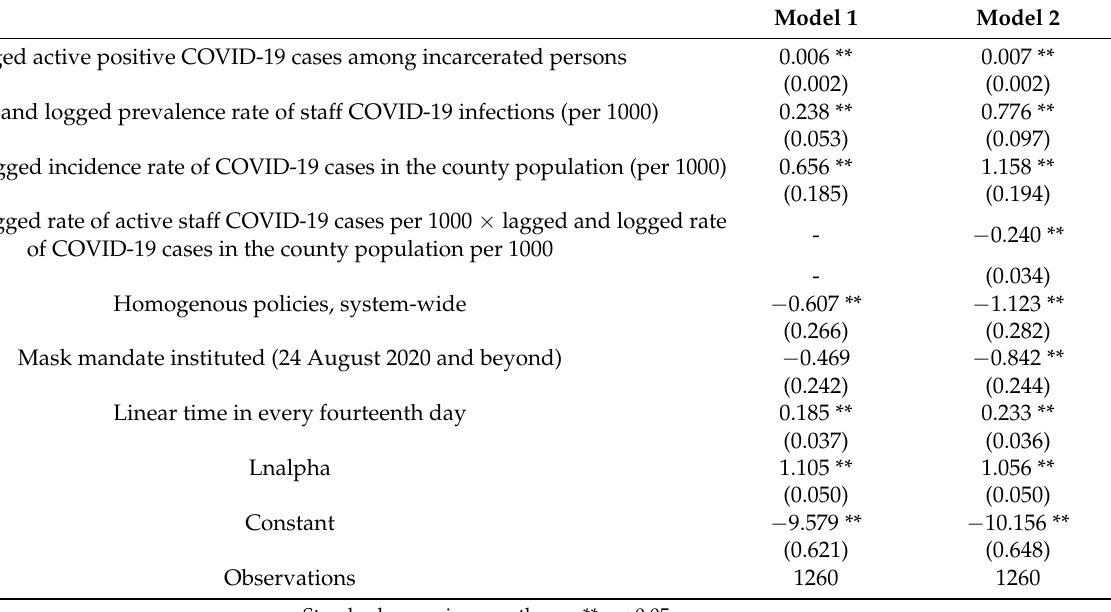
Table 2. Population standardized regressions with prison fixed effects predicting the active cases of COVID-19 among incarcerated persons (fixed effects suppressed; full models in Table A1, available in Appendix A).